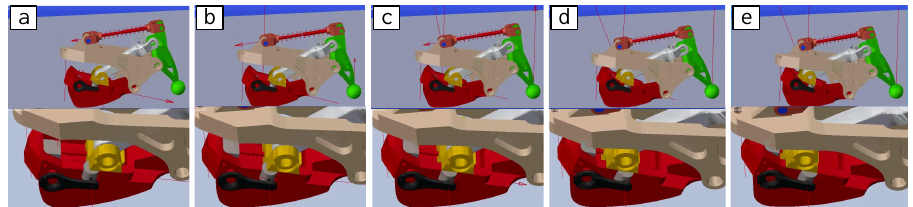
Figure 11. The snapshots of the bionic mechanism simulation. The fixation rod is constrained to move only vertically up and down. As the downward pressure increases, the slider pushes away from the cylinder and moves backwards on the